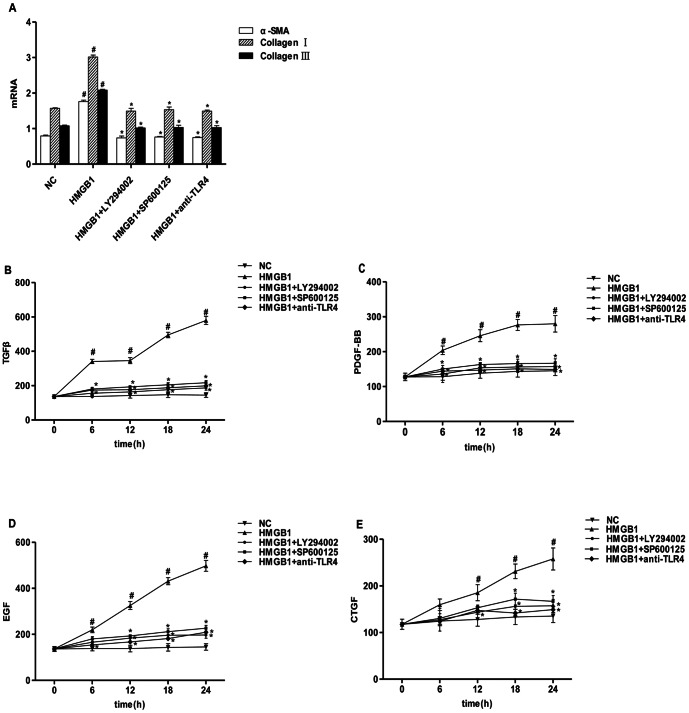
TLR4-dependent JNK and PI3K/Akt were involved in HMGB1-induced HSCs pro-fibrotic effects.A: HMGB1 enhanced the level of α-SMA, collagen I, collagen III mRNA in primary human HSCs, whereas SP600125, LY294002 and TLR4 neutralizing antibody decreased the level. α-SMA, collagen I, collagen III/GAPDH were considered as the relative mRNA level. Data are expressed as mean ± SEM (n = 6). #P<0.05, compared with the control group;*P<0.05, compared with the HMGB1-stimulated group. B: HMGB1 enhanced the level of TGF-β1 produced by HSCs, whereas SP600125, LY294002 and TLR4 neutralizing antibody decreased that enhancement markedly. C: HMGB1 enhanced the level of PDGF-BB produced by HSCs, whereas SP600125, LY294002 and TLR4 neutralizing antibody decreased that enhancement markedly D: HMGB1 enhanced the level of CTGF produced by HSCs, whereas SP600125, LY294002 and TLR4 neutralizing antibody decreased that enhancement markedly E: HMGB1 enhanced the level of EGF produced by HSCs, whereas SP600125, LY294002 and TLR4 neutralizing antibody decreased that enhancement markedly Data in subfigures B–E are all presented as mean ± SEM (n = 6). # P<0.05, compared with the control group at the same time; * P<0.05, compared with the HMGB1 group at the same time.